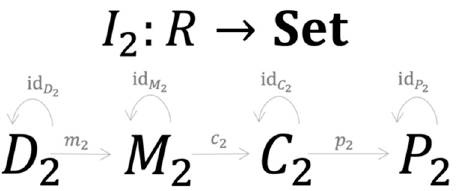
Figure 5. A specific credit risk model is a C-Instance of category 𝑅. Assume the set-valued functor I 2 performs the mapping as set out of Figure